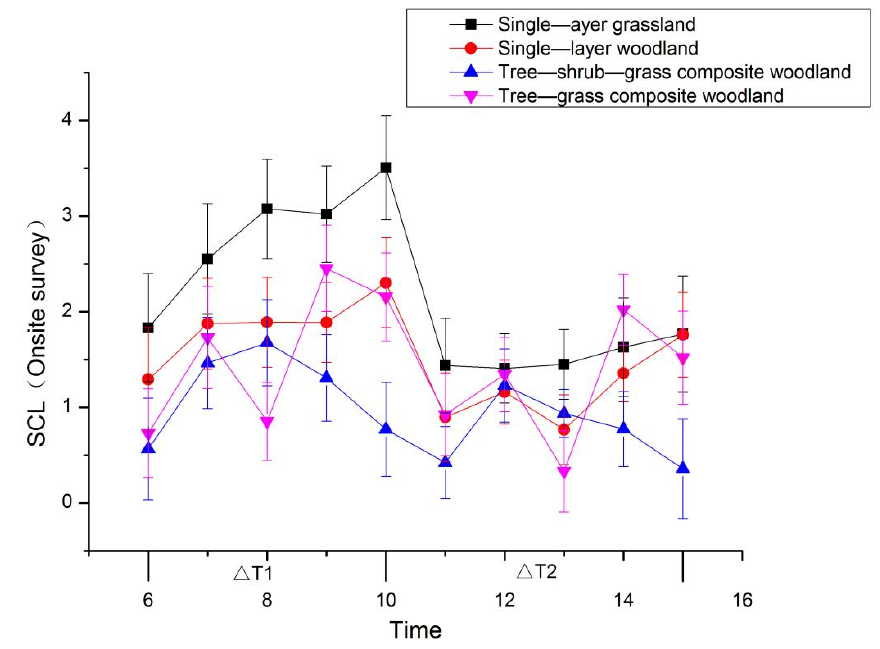
Figure 5. Impact of onsite surveys on participant SCL indicators.